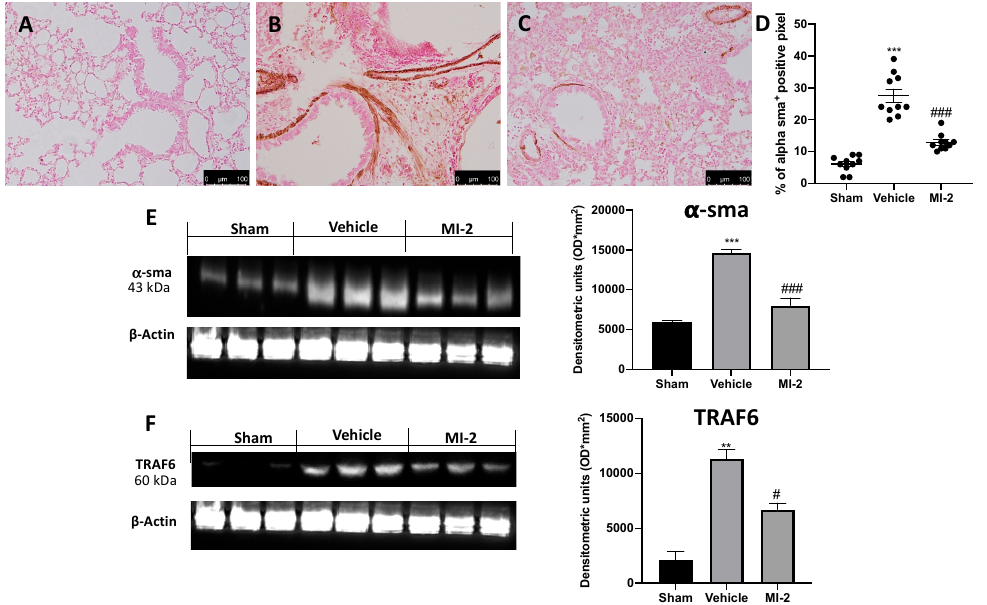
Figure 7. Effect of MI-2 on α -sma and TRAF6 expression: Immunohistochemical analysis of α -sma: sham ( A ), vehicle ( B ), MI-2 ( C ), % of positive pixels ( D ). Western blot analysis of α -sma ( E ) and TRAF6 ( F ). For each analysis, n = 10 animals from each group were employed.